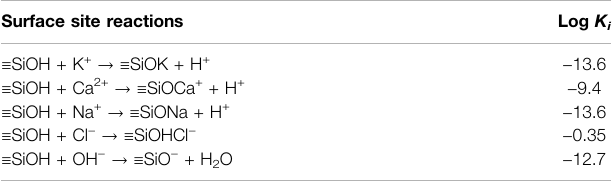
TABLE 1 | Equilibrium constants of the surface site reactions at 25 ° C (Elakneswaran et al., 2010). Surface site